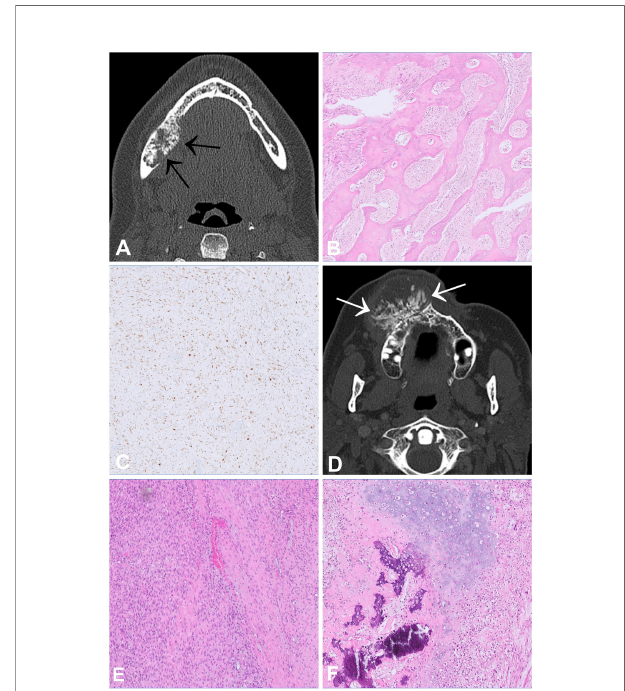
FIGURE 4 | Low-grade central (A – C) and high-grade central (D – F) osteosarcoma. (A) CT scan showing a slightly expansive tumour within the right lower jaw with irregular mineralisation and aggressive growth, which permeates the cortex (arrows). (B) Histologically, low grade osteosarcoma shows irregular bone trabeculae embedded in fi broblastic stroma with only subtle atypia and low to moderate cellularity. (C) The tumour cells are posittive for MDM2 on immunohistochemistry. (D) CT scan showing a huge and aggressive mass with ossi fi cation arising in the right maxilla and bulging outward exophytically. (E, F) Morphological appearance of a high-grade osteosarcoma showing atypical spindle and epithelioid cells with associated malignant osteoid deposition and areas of cartilaginous differentiation (F)